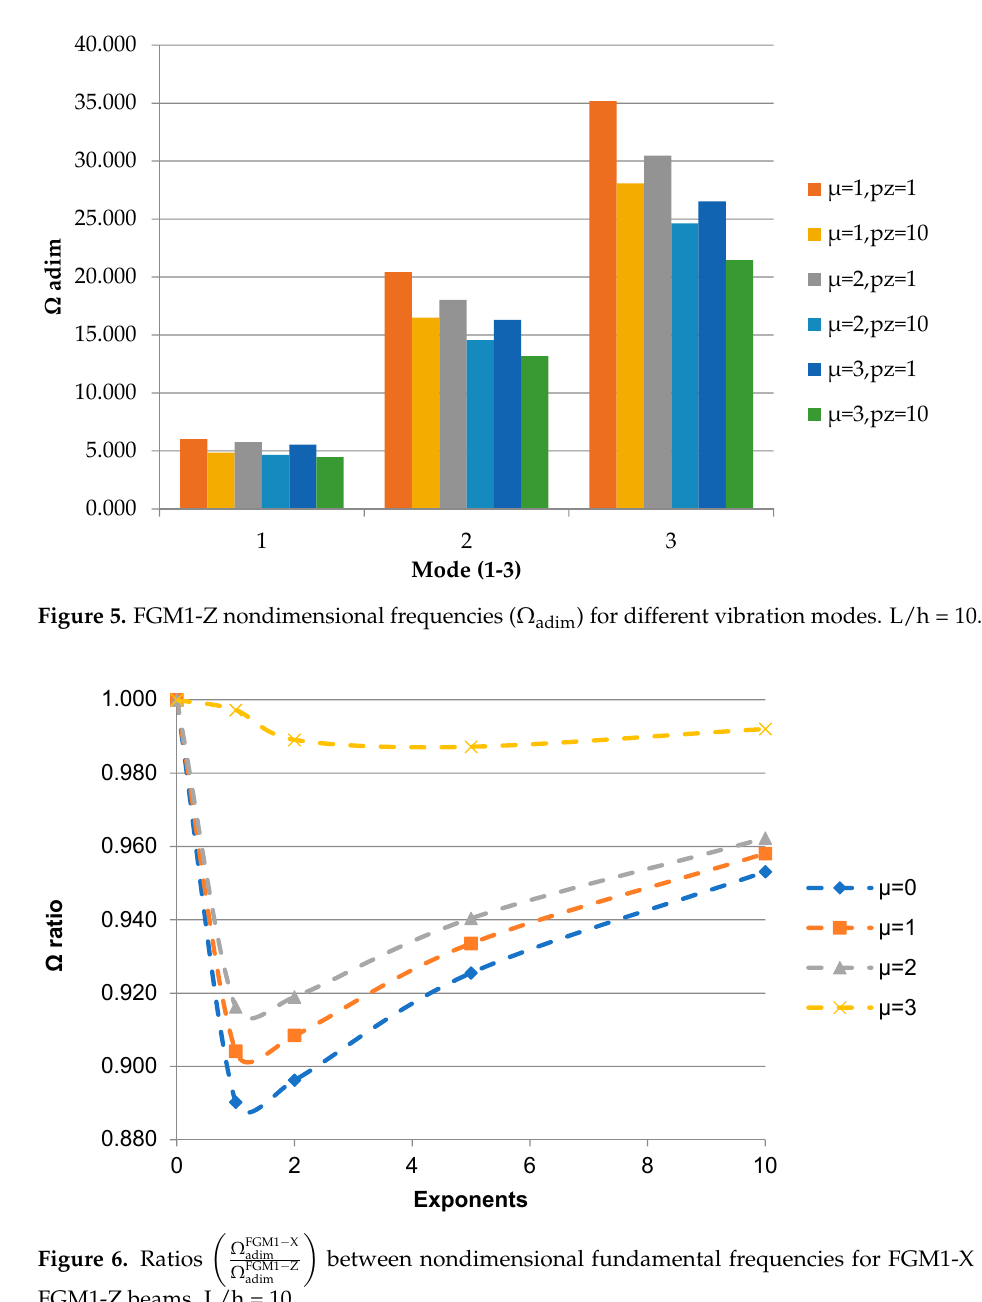
(cid:18) (cid:19) Ω FGM1 − X (cid:3138)(cid:3139)(cid:3145)(cid:3117)(cid:3127)(cid:3156) Figure 6. Ratios between nondimensional fundamental frequencies for FGM1-X and adim (cid:3440) between nondimensional fundamental frequencies for FGM1-X and Figure 6. Ratios (cid:3436) (cid:2960) (cid:3159)(cid:3162)(cid:3167)(cid:3171) Ω FGM1 − Z (cid:2960) (cid:3159)(cid:3162)(cid:3167)(cid:3171)(cid:3138)(cid:3139)(cid:3145)(cid:3117)(cid:3127)(cid:3158) adim FGM1-Z beams. L/h = FGM1-Z beams. L/h = 10.